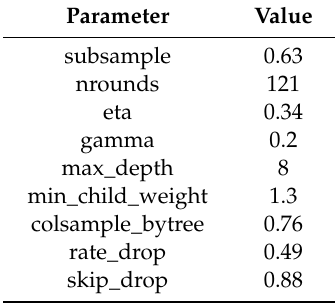
Table A1. Applied hyperparameter settings of the Extreme Gradient Boosting